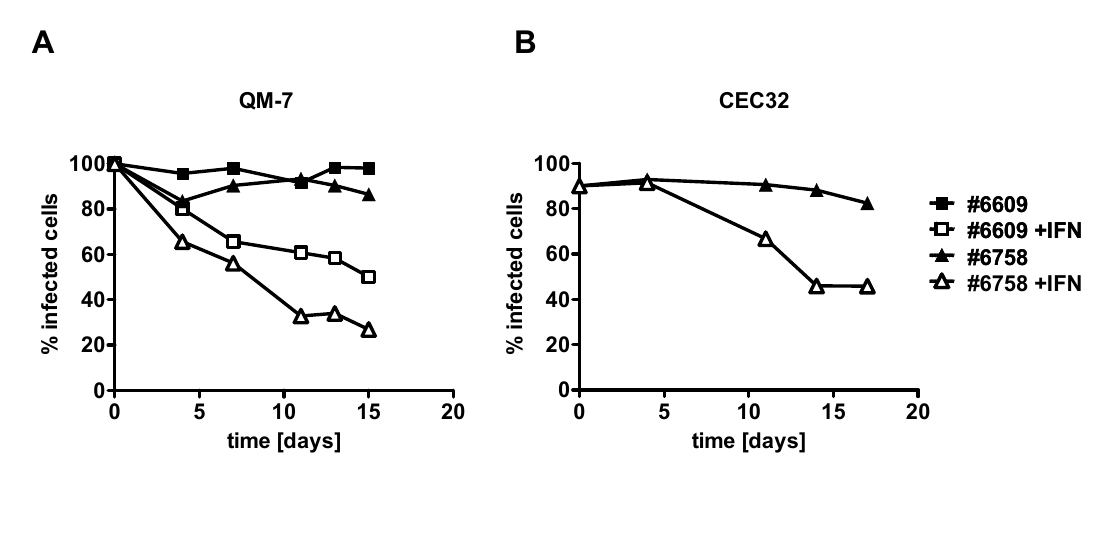
Figure 3. Effect of chicken IFN- α on quail cells persistently infected with ABV strains #6758 or #6609. Persistently infected QM-7 (A) or CEC32 (B) cells were kept in culture medium containing 100 units per ml of chicken IFN- α (open symbols) or plain medium (closed symbols). Virus inhibition over time was measured by visualizing ABV-N-positive cells in culture samples using indirect immunofluorescence analysis and by calculating the percentage of virus-infected